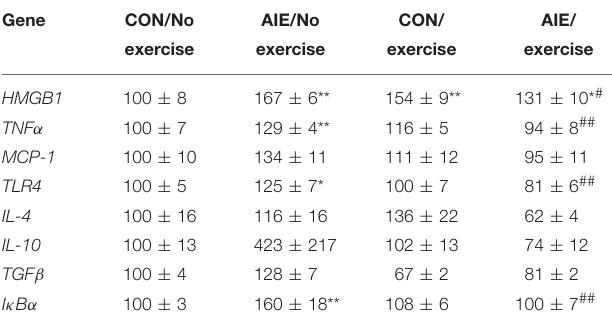
TABLE 3 | Effect of adolescent intermittent ethanol (AIE) and/or exercise on expression of neuroimmune signaling genes in the adult brain (P80).